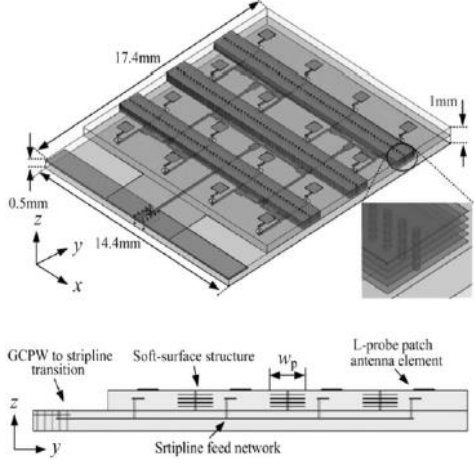
Figure 2: The L-probe patch array antenna